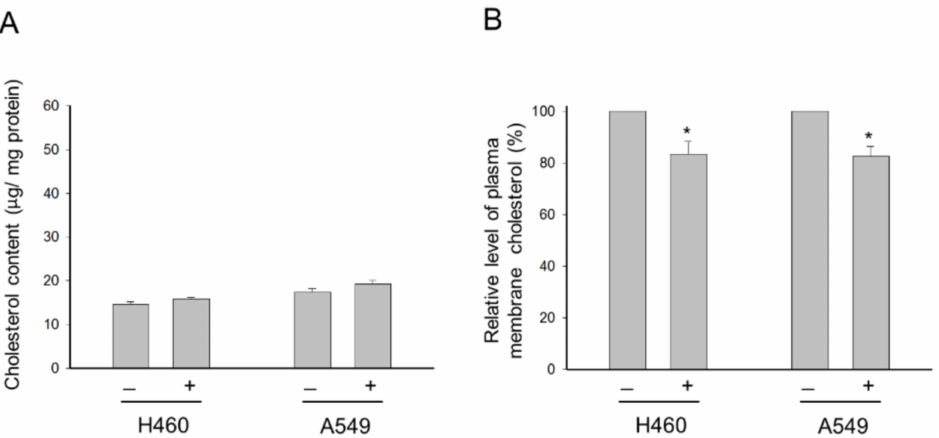
Figure 4. Effect of para -toluenesulfonamide on cholesterol content. NCI-H460 and A549 cells were incubated in the absence or presence of 6 mM para -toluenesulfonamide for 24 h. ( A ) The level of total cellular cholesterol was examined using the Cholesterol Assay Kit. ( B ) Plasma membrane fraction was isolated by sucrose density gradient centrifugation, and the level of cholesterol on plasma membrane was examined using the Cholesterol Assay Kit. Na + /K + ATPase a1-subunit was used as internal control. The data are expressed as mean ± SEM of three independent determinations. * p < 0.05 compared with the